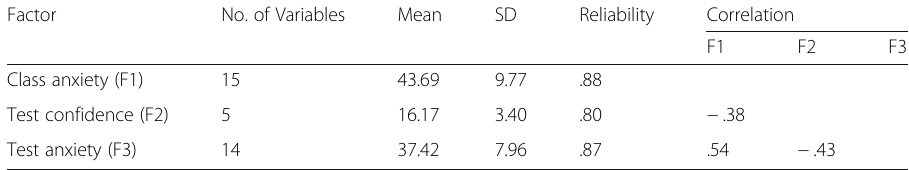
Table 5 Descriptive statistics, reliabilities, and zero-order correlations of anxiety factors